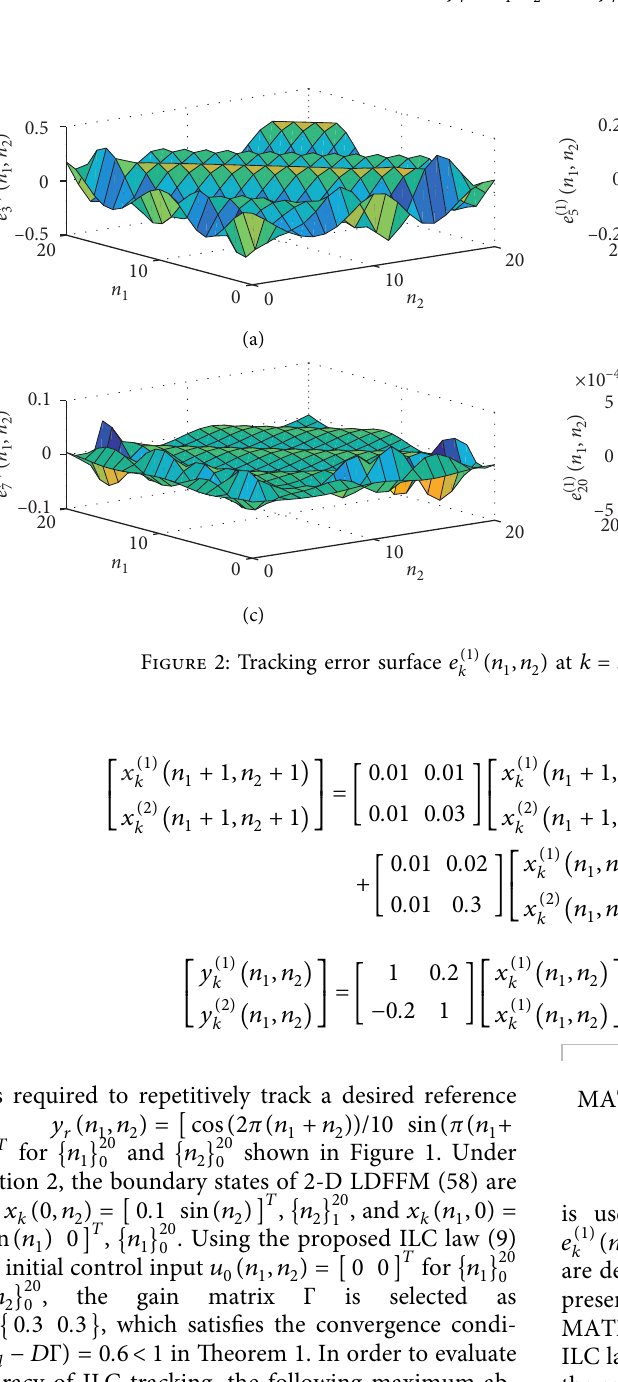
( n , n ) and y ( 2 ) r 1 2